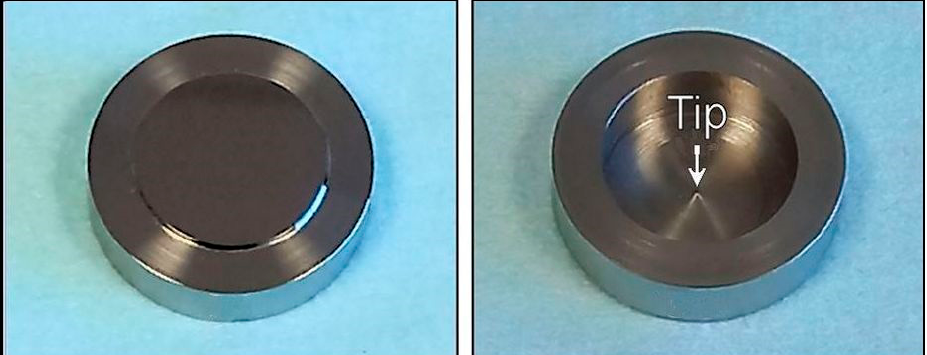
Figure 16. View of prototype tulip ‐ like VCM#5 with its rear central tip.